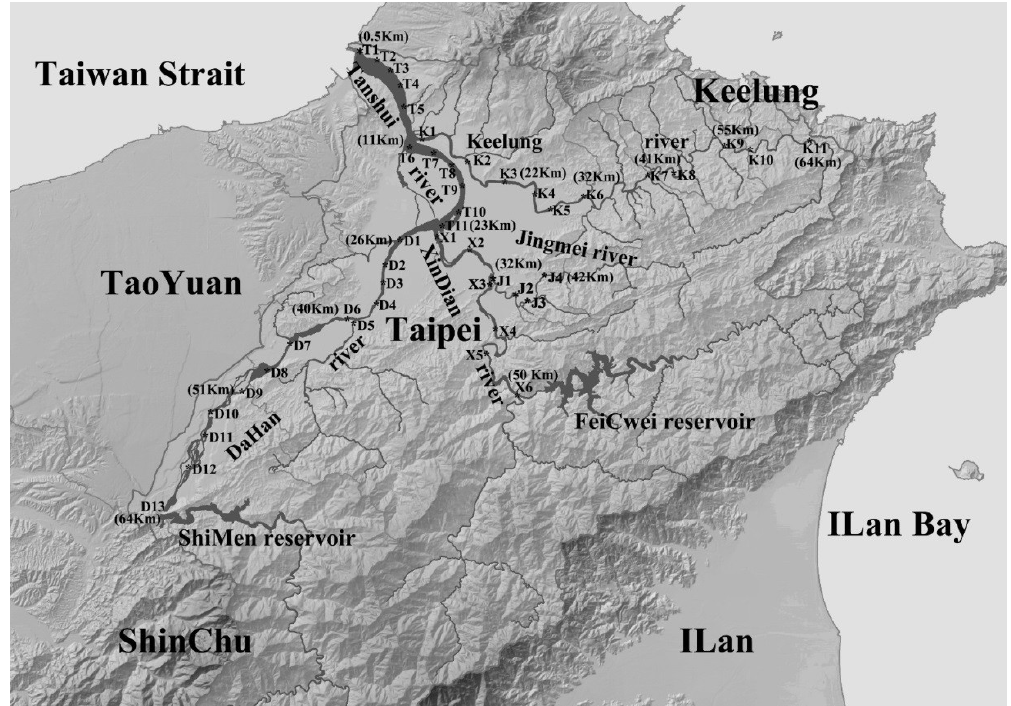
Figure 1. Tanshui River system and sampling site on each branch. T1-T11 for Tanshui River, K1-K11 for Keelung River, X1-X6 for Xindian River, J1-J4 for Jingmei River and D1-D13 for Dahan River. The distance to the sea of the flow track for each sampling site is indicate in parentheses